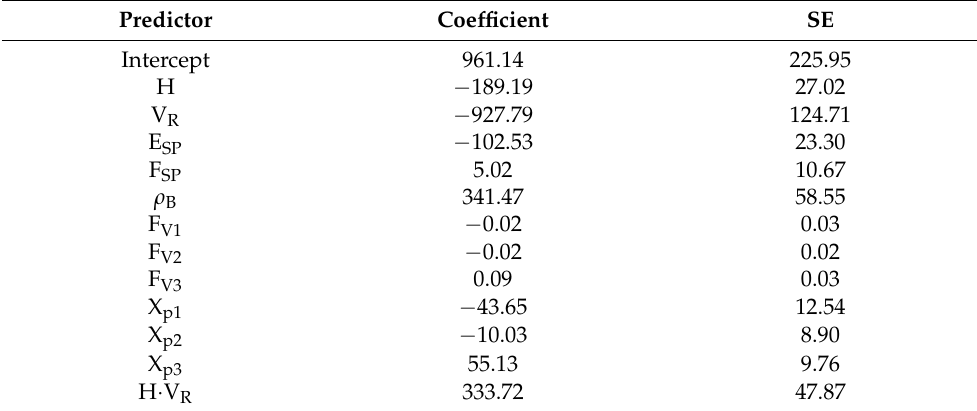
Table 5. Linear regression coefficients.